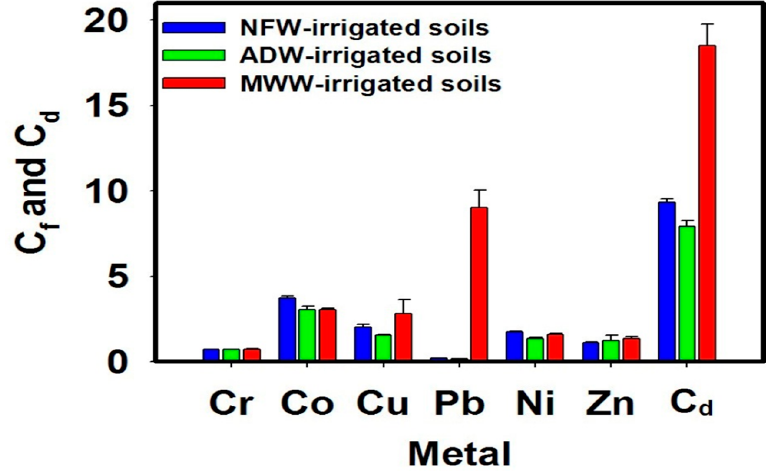
Figure 2. Contamination factor (C f ) and contamination degree (C d ).